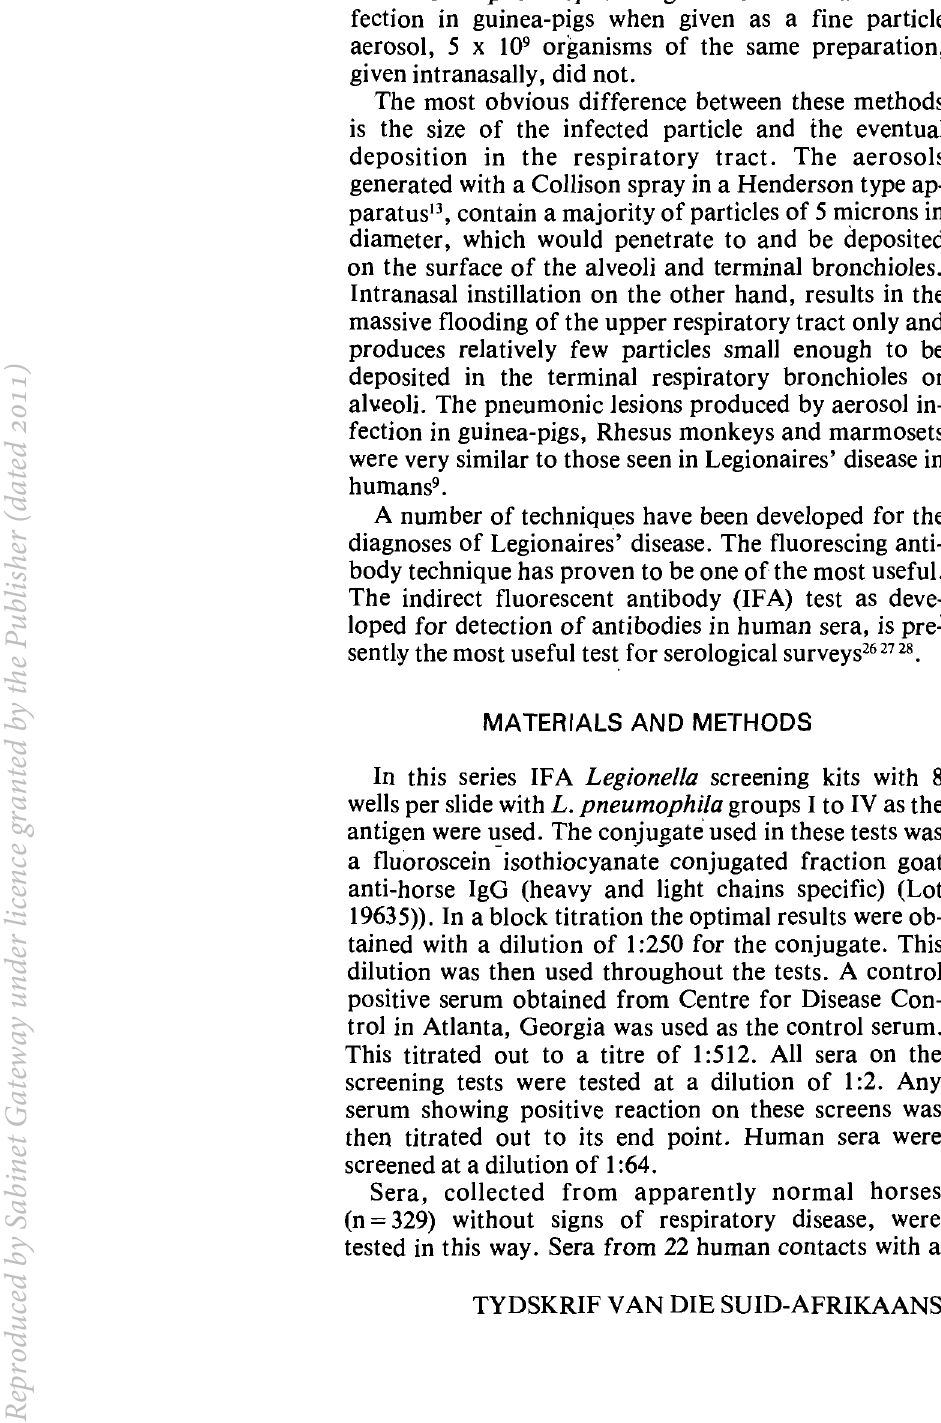
Table 1: The number of horses showing a positive reaction to L.pneumophila